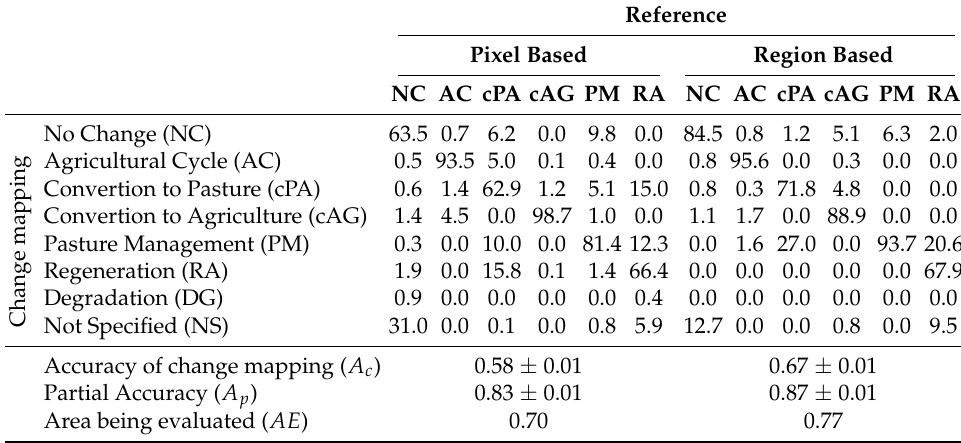
Table 4. Mean rectangular confusion matrices (%) and mean evaluation indexes for final change mappings using L1 legend.